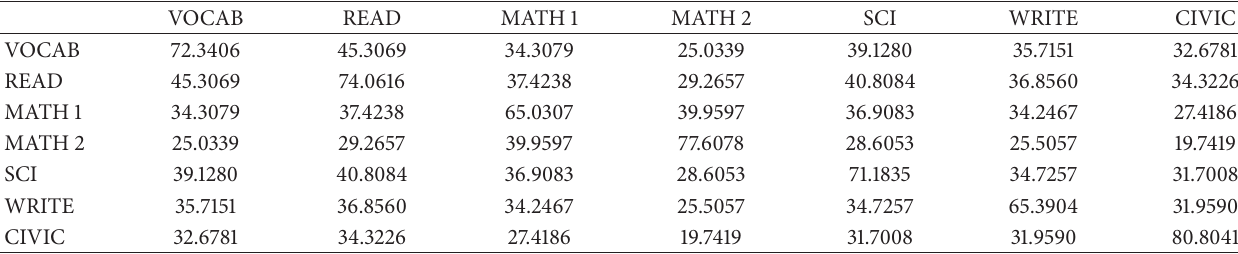
Table 4: Posterior mean for Σ .